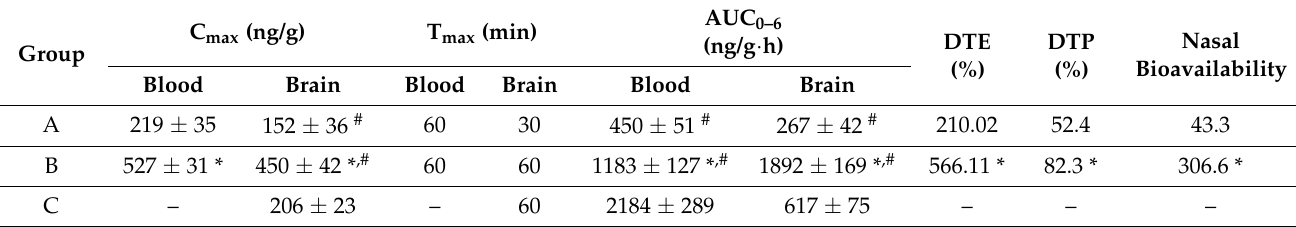
Table 2. Pharmacokinetic parameters, drug targeting efficiency (DTE, %), drug transport percentage (DTP, %) and nasal bioavailability of naringin formulations namely naringin suspension (group A) administered intranasally and naringin loaded in situ gelling nanoemulgel given by intranasal (group B) and intravenous routes (group C).